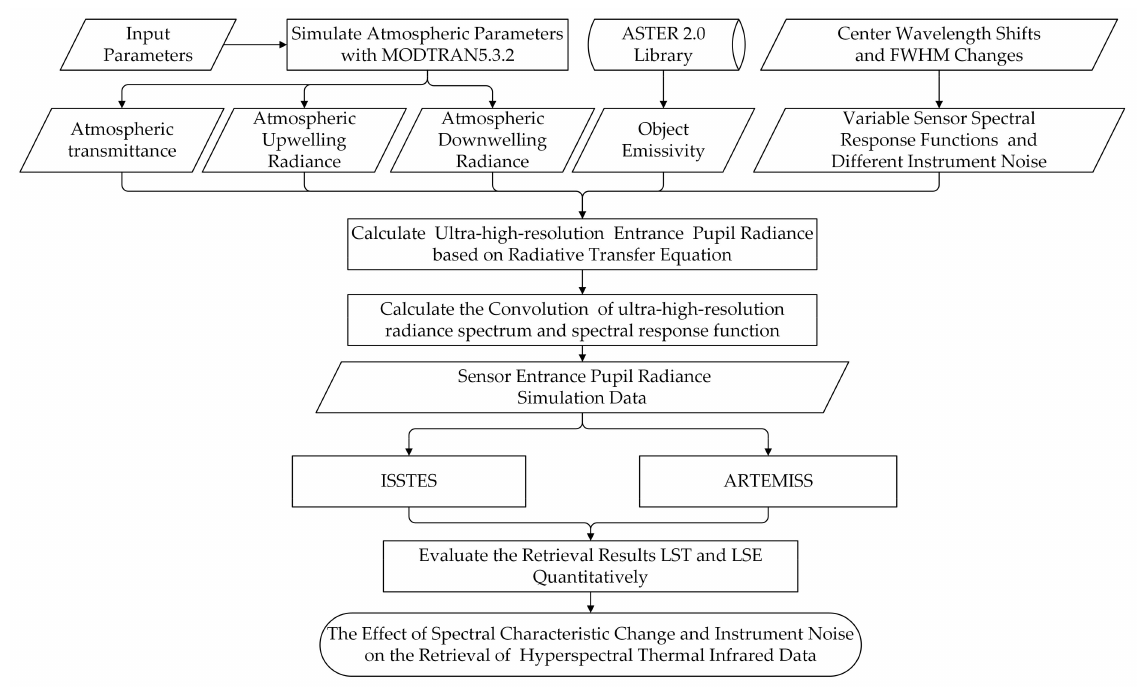
Figure 1. The flowchart of simulated at-sensor radiance generation, retrieval and results